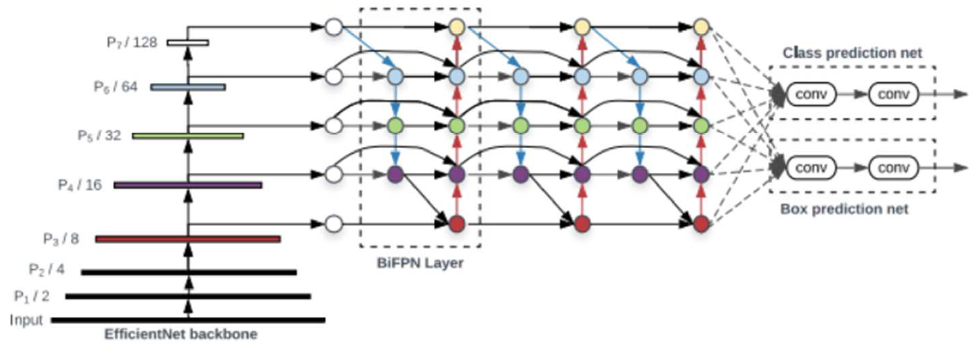
Figure 3. YOLOv5 architecture [16].